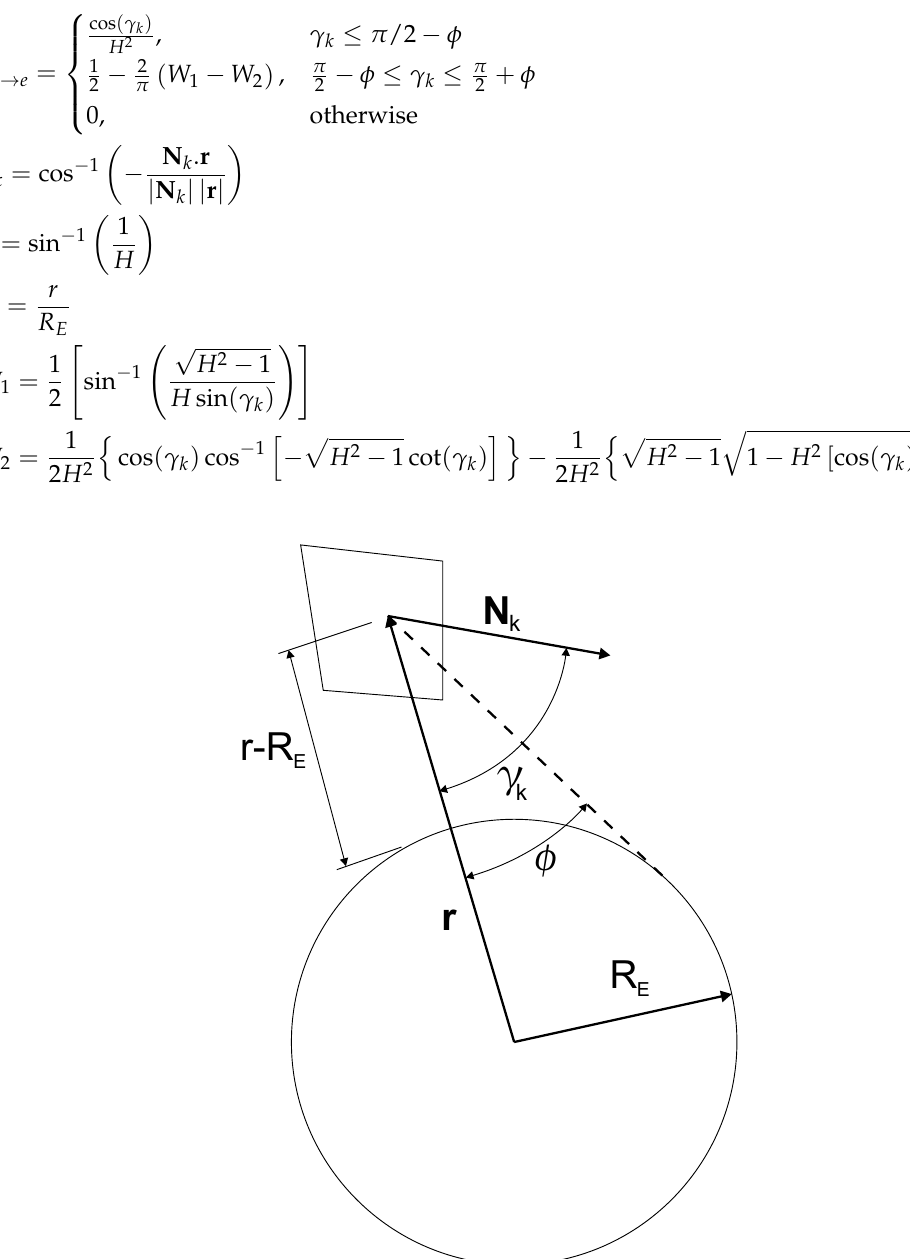
Figure 5. Geometry to estimate F k → e